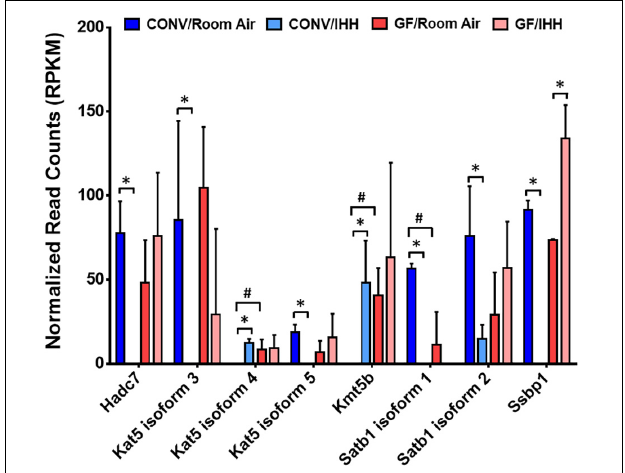
FIGURE 7 | Intermittent hypoxia/hypercapnia exposure-induced changes of epigenomic modifiers in the heart of CONV mice. The expressional abundance of the differentially expressed genes (DEGs) was presented as mean ± SD for each condition. *: DEGs in CONV mice under IHH (| Fold Change| > 1.5 and Benjamini–Hochberg adjusted p < 0.05). #: DEGs between GF and CONV mice under room air condition (| Fold Change| > 1.5,